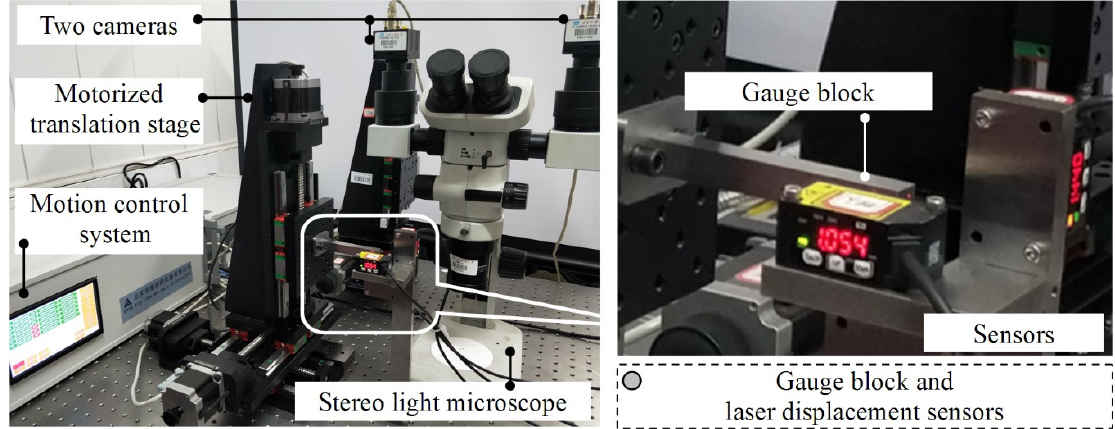
Figure 6. The photo of the experiment system. The system consists of an Olympus SZX7-style stereo light microscope, a 3-axis motorized translation stage with a positioning precision of 1 μ m, three Panasonic-style laser displacement sensors with a precision of 10 μ m and a gauge block with size of 90 mm(length) × 5 mm(width) × 5 mm(height) and surface roughness of 0.8 μ m.